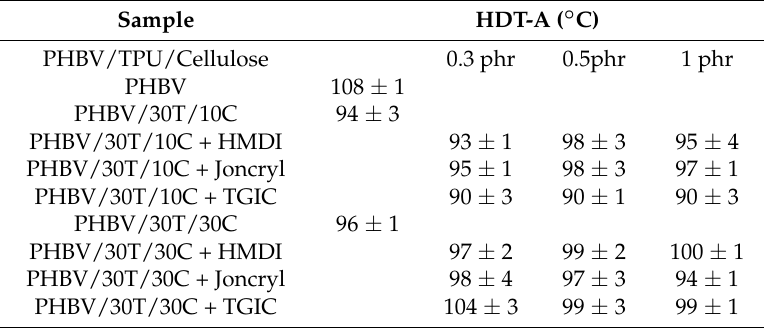
Table 3. HDT-A values for neat PHBV and PHBV/TPU/cellulose systems with and without reactive